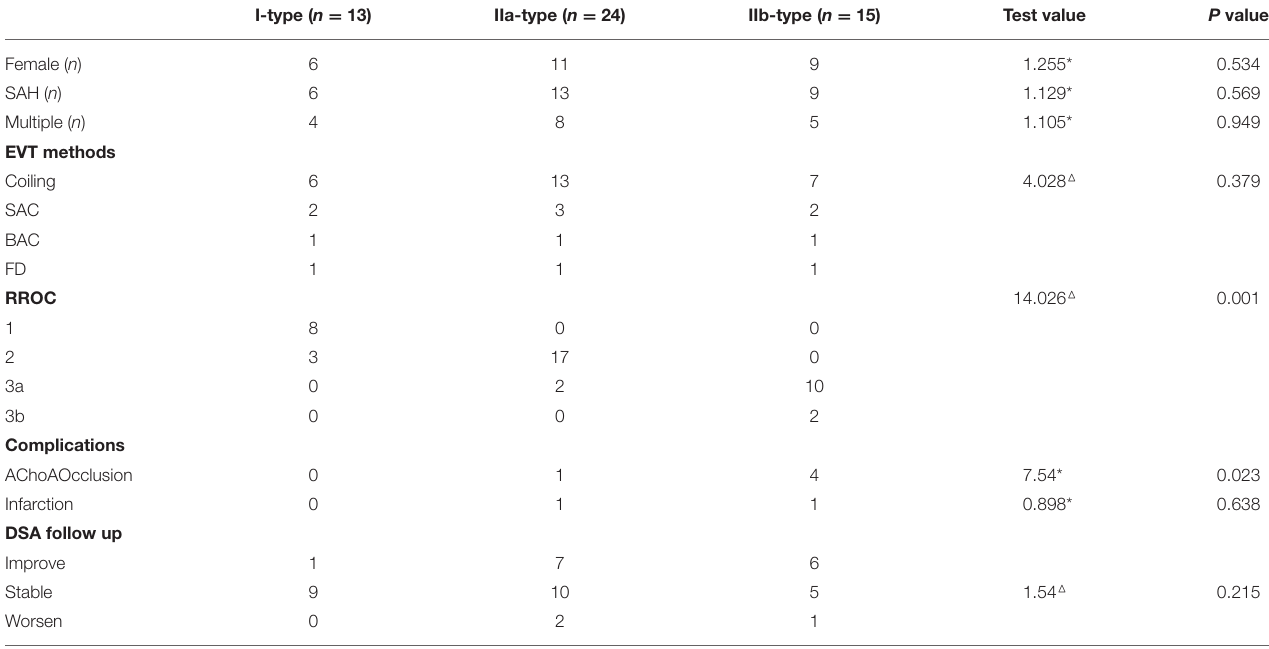
TABLE 1 | The characteristics of the different